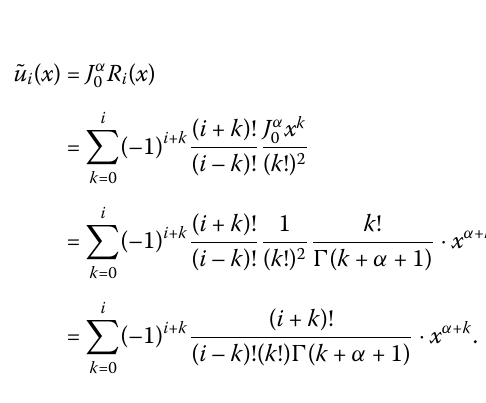
Figure 2 The comparison of the approximate solution and the exact solution when m = 8